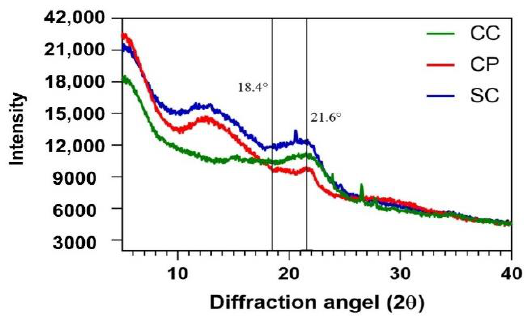
Figure 2. The X-ray diffraction (XRD) spectra of lignocellulosic biomasses, including corn cob (CC), cornstalk piths (CP) and sugarcane bagasse (SC).